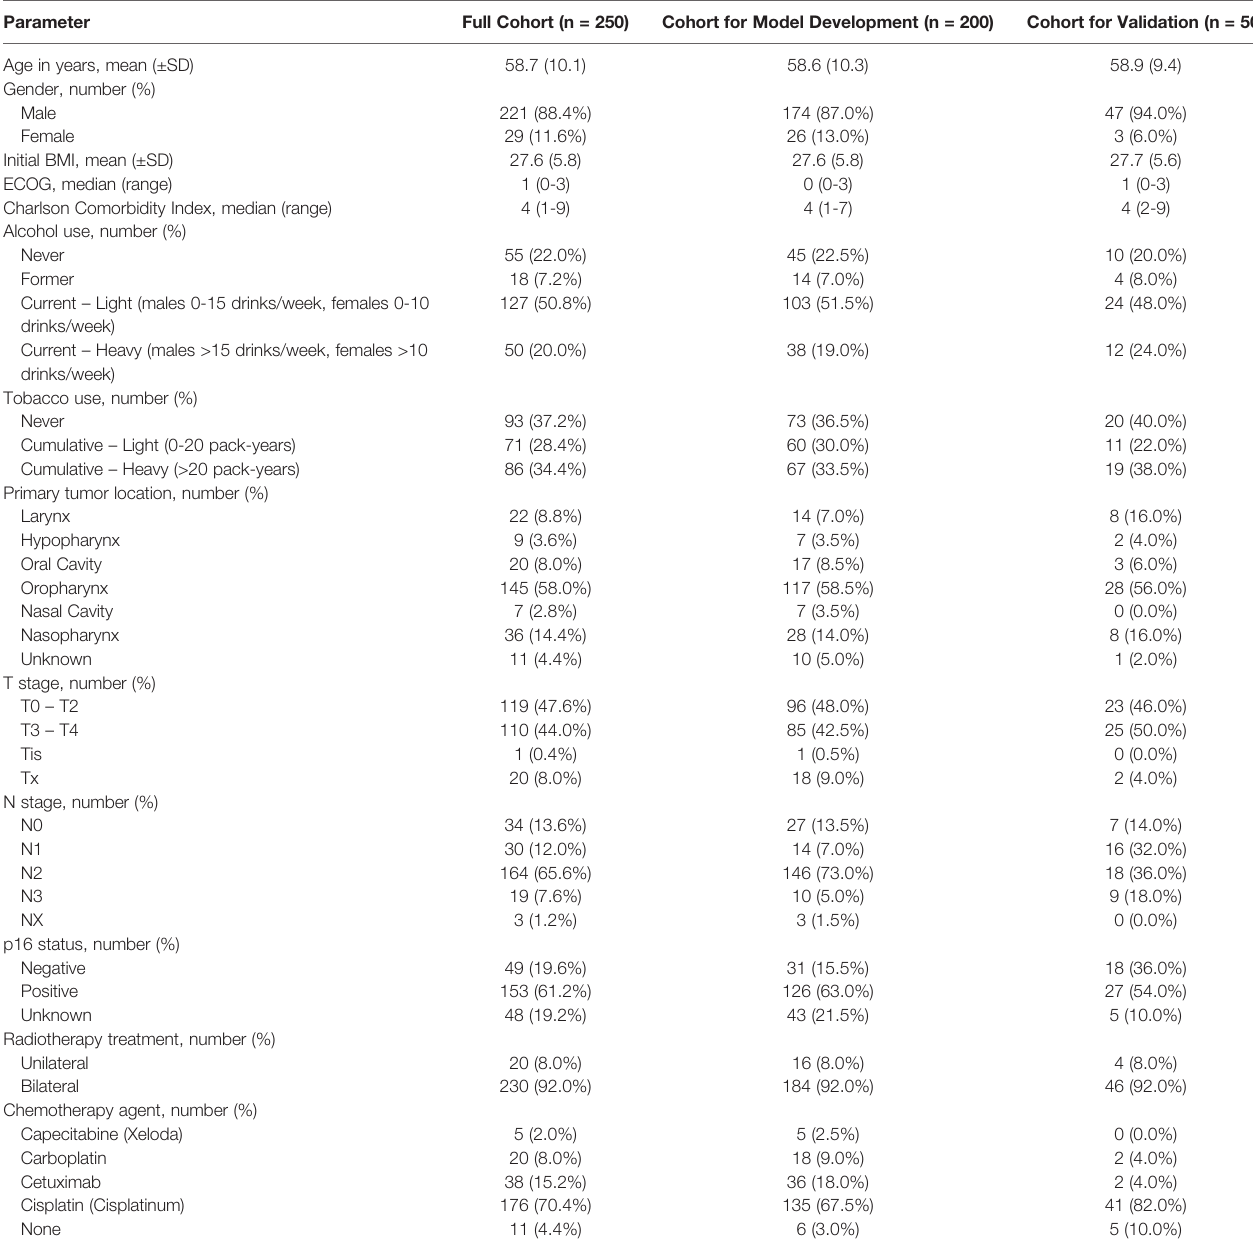
TABLE 4 | Cohort demographic and clinical characteristics.